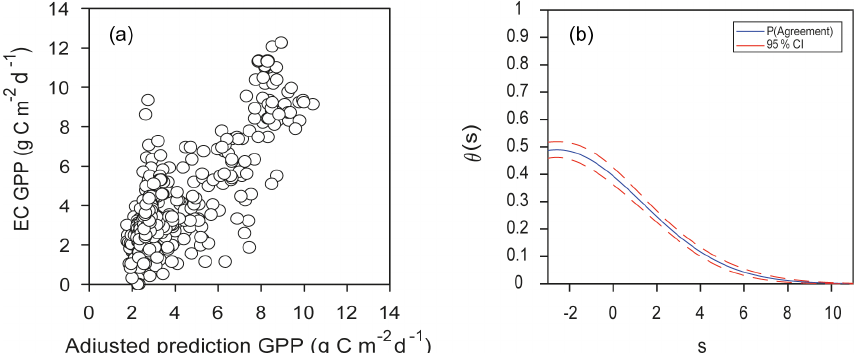
Figure 10. (a) Adjusted predictions of GPP for the complete dataset from the Bernal site using the leader model of the final ensemble of machine learning algorithms (EML) derived from the Santa Rita site compared to estimates of GPP from EC data, with r = 0 . 78. (b) Respective function of probability of agreement using 1gCm − 2 d − 1 as a tolerable agreement between methods of estimation of GPP: EC data from the Bernal site and EML model for the Santa Rita site. The horizontal axis ( s ) represents the magnitude of the measurement, the vertical axis is the probability of agreement for the measurement, and the red line is the confidence interval p < 0 . 05